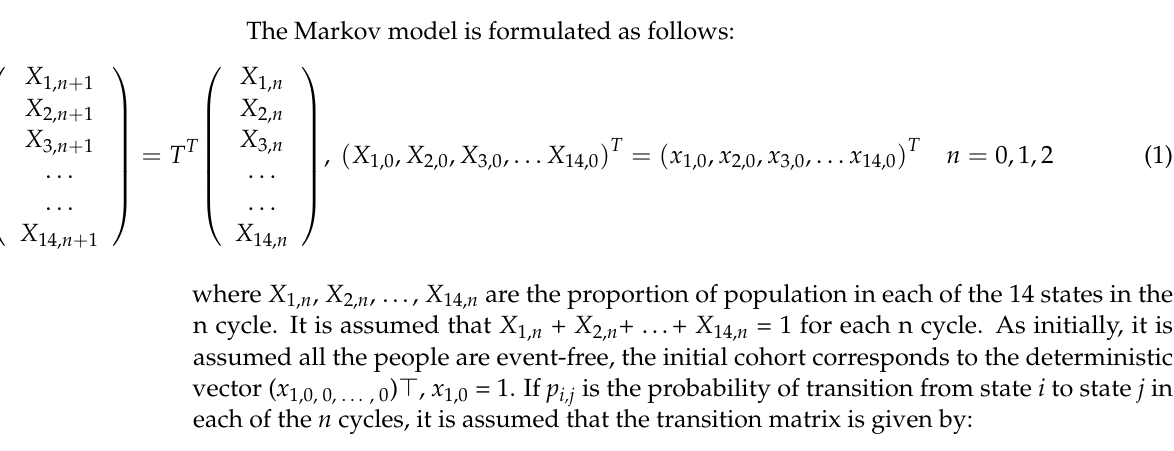
Figure 1. Diagram of the Markov model. States and transitions. Source: prepared by the authors. The Markov model is formulated as follows: ⎝ ⎜⎜⎛ 𝑋 (cid:2869),(cid:3041)(cid:2878)(cid:2869) 𝑋 (cid:2870),(cid:3041)(cid:2878)(cid:2869) 𝑋 (cid:2871),(cid:3041)(cid:2878)(cid:2869) . . . . 𝑋 (cid:2869)(cid:2872),(cid:3041)(cid:2878)(cid:2869) ⎠ ⎟⎟⎞ = 𝑇 (cid:3021) ⎝ ⎜⎜⎛ 𝑋 (cid:2869),(cid:3041) 𝑋 (cid:2870),(cid:3041) 𝑋 (cid:2871),(cid:3041) . . . . 𝑋 (cid:2869)(cid:2872),(cid:3041) ⎠ ⎟⎟⎞ , (cid:3435)𝑋 (cid:2869),(cid:2868) , 𝑋 (cid:2870),(cid:2868) , 𝑋 (cid:2871),(cid:2868) , … … . . 𝑋 (cid:2869)(cid:2872),(cid:2868) (cid:3439) (cid:3021) = (cid:3435)𝑥 (cid:2869),(cid:2868) , 𝑥 (cid:2870),(cid:2868) , 𝑥 (cid:2871),(cid:2868) , … … . . 𝑥 (cid:2869)(cid:2872),(cid:2868) (cid:3439) (cid:3021) n = 0,1,2